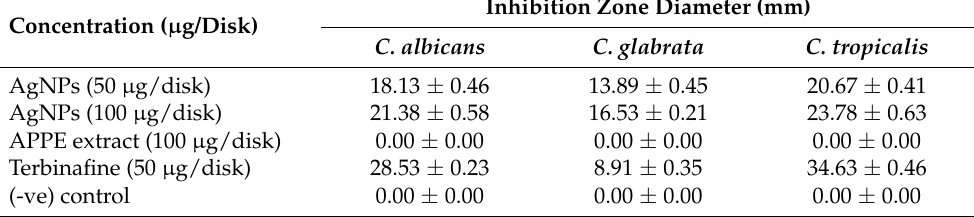
Table 2. Screening of antimicrobial efficiency of P. granatum silver nanoparticles against the concerned candidal strains.